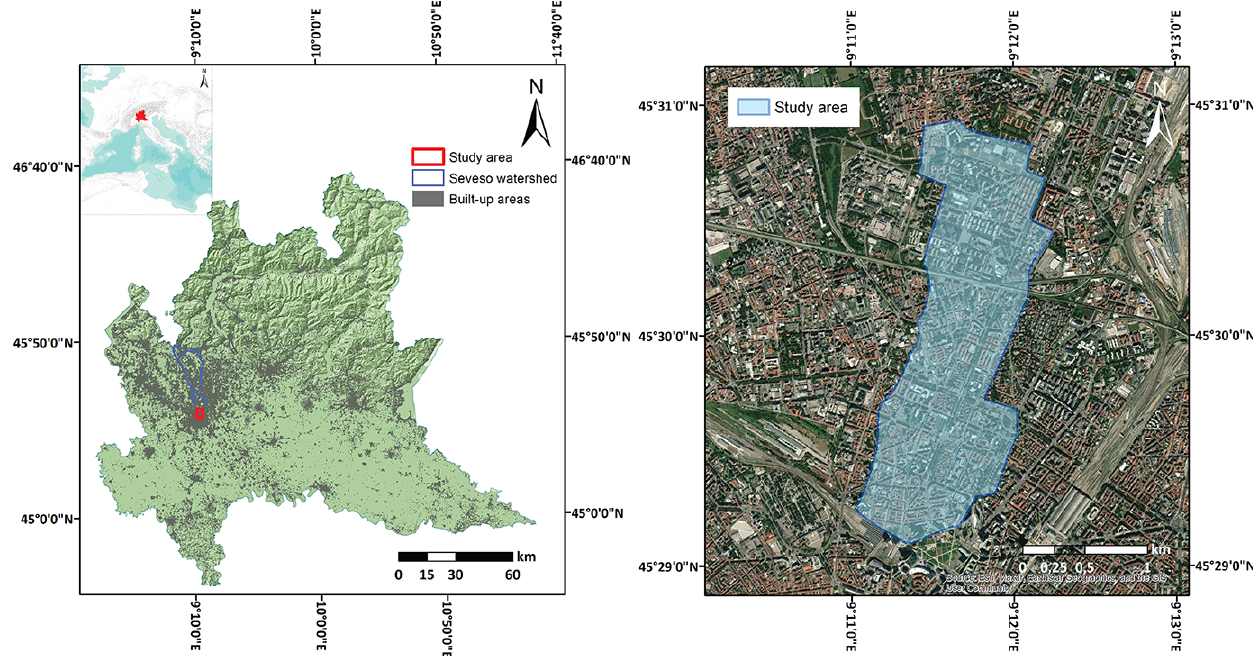
Figure 1. Investigation area and survey of inundated area of the 2014 Seveso flood in Milan. Base map and DTM from © Regione Lombardia 2022. Built-up-area shapefile is from © OpenStreetMap contributors 2022. Distributed under the Open Data Commons Open Database License (ODbL) v1.0. Satellite image is from © Google Earth